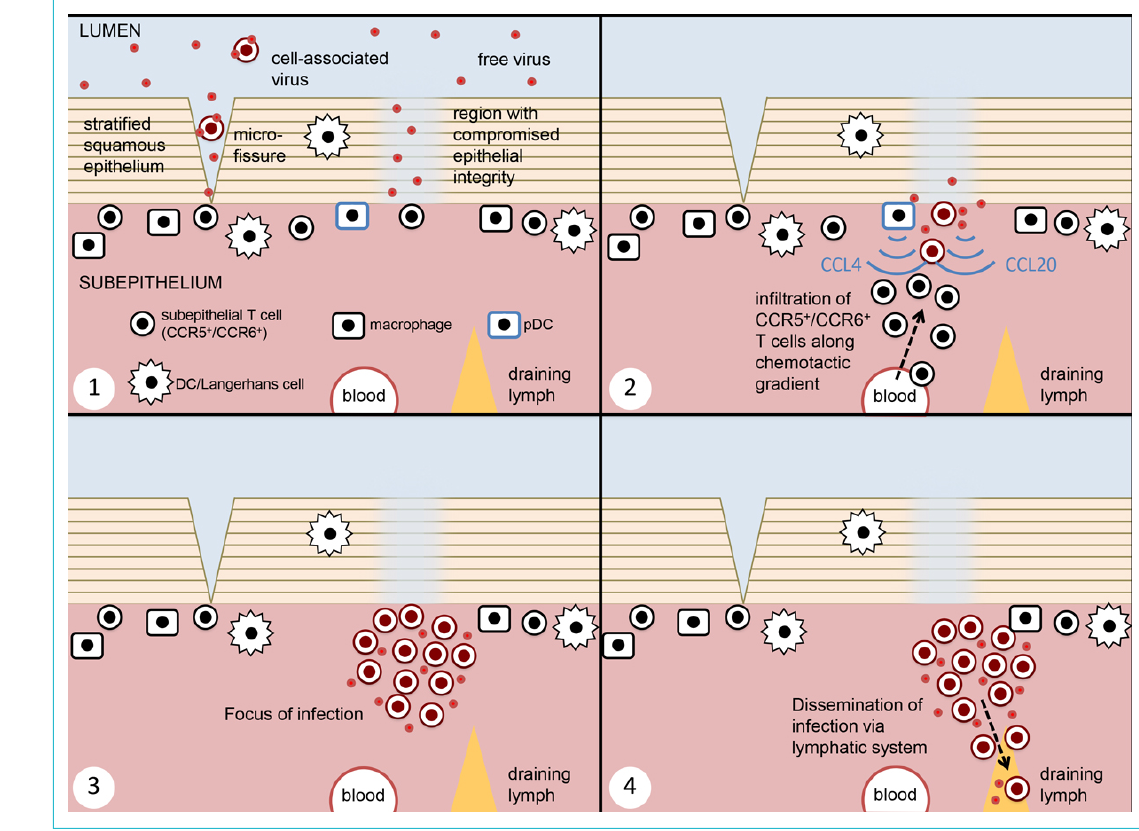
Figure 1: Current understanding of mucosal transmission of HIV. This figure represents infection across a squamous epithelial barrier (e.g. vagina and penile foreskin), the mechanism which has been most extensively studied. 1. Challenge arrives in the form of both cell-free and cell-associated virus, with entry at points of reduced epithelial integrity. 2. The initially infected cells are believed to be submucosal CCR5+ CD4 T cells. At sites of initial infection, both epithelial damage and innate antiviral responses lead to the release of chemokines, leading to re- cruitment of susceptible target cells. 3. This leads to the formation of a focus of infection, generating a population of founder virus. 4. Free and cell-associated virus from the founder population enters the lymphatic system, leading to the establishment of systemic